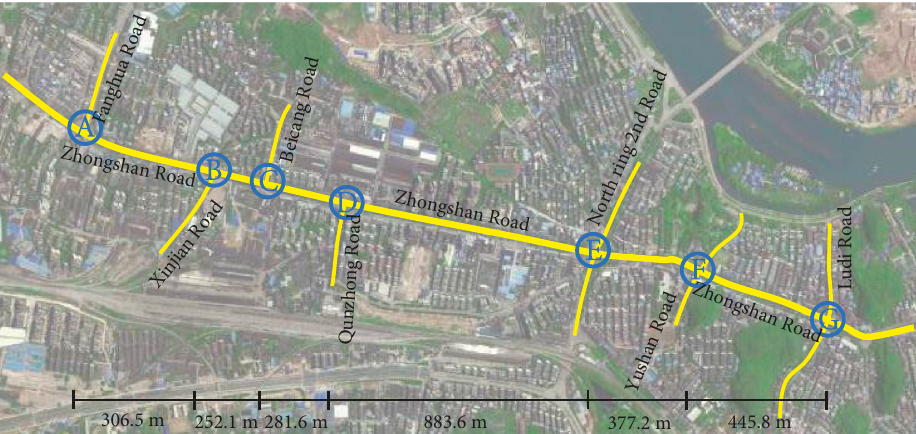
Figure 5: Experimental location and equipment.